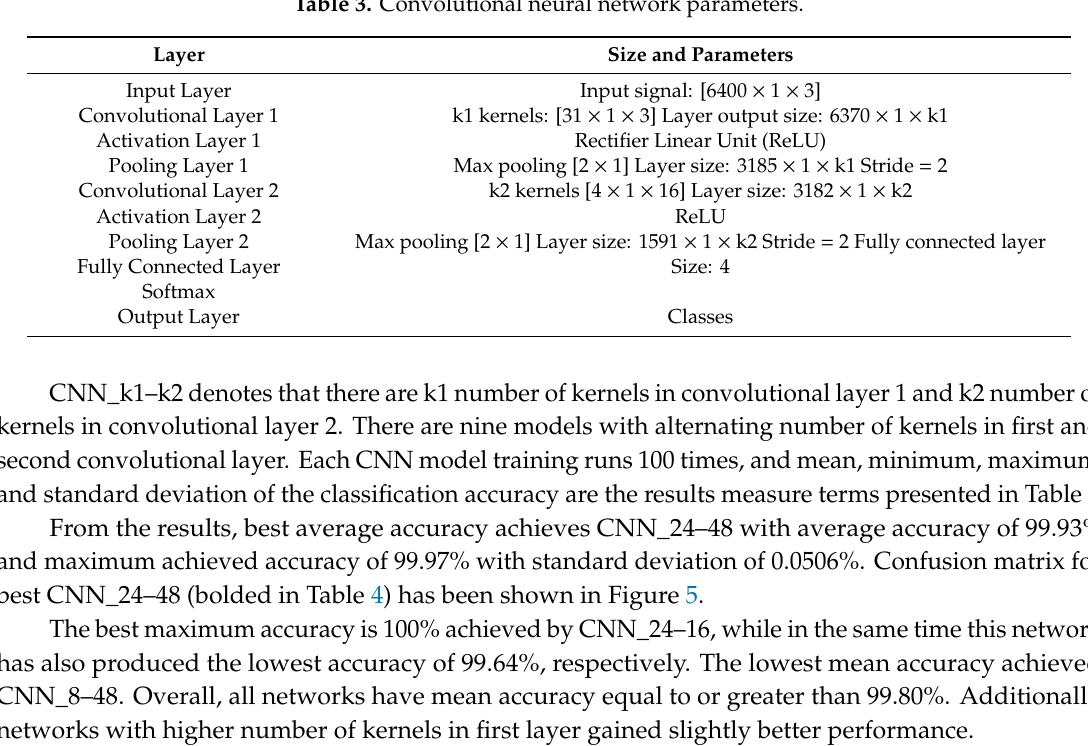
Table 3. Convolutional neural network parameters.